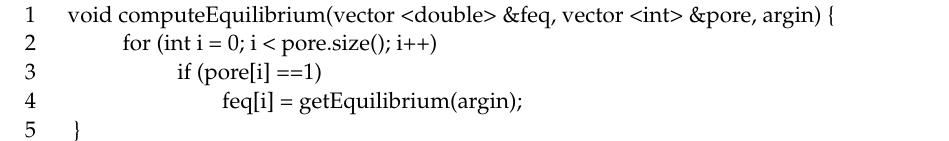
Algorithm 1 . Computation of equilibrium distribution with direct addressing—vector “pore” stores domain information, vector “feq” stores equilibrium distribution, and “argin” is for additional variables, such as density and velocity